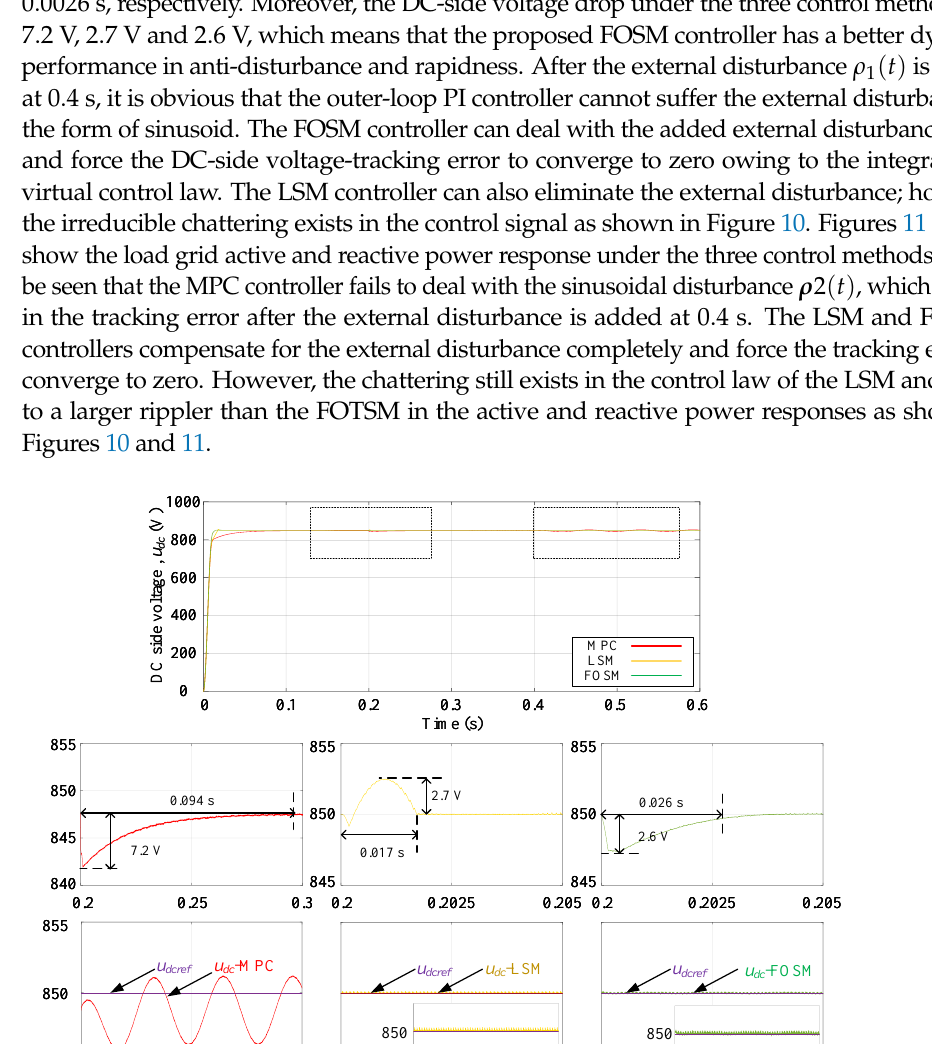
Figure 9. The DC-side voltage responses under the MPC, the LSM and the